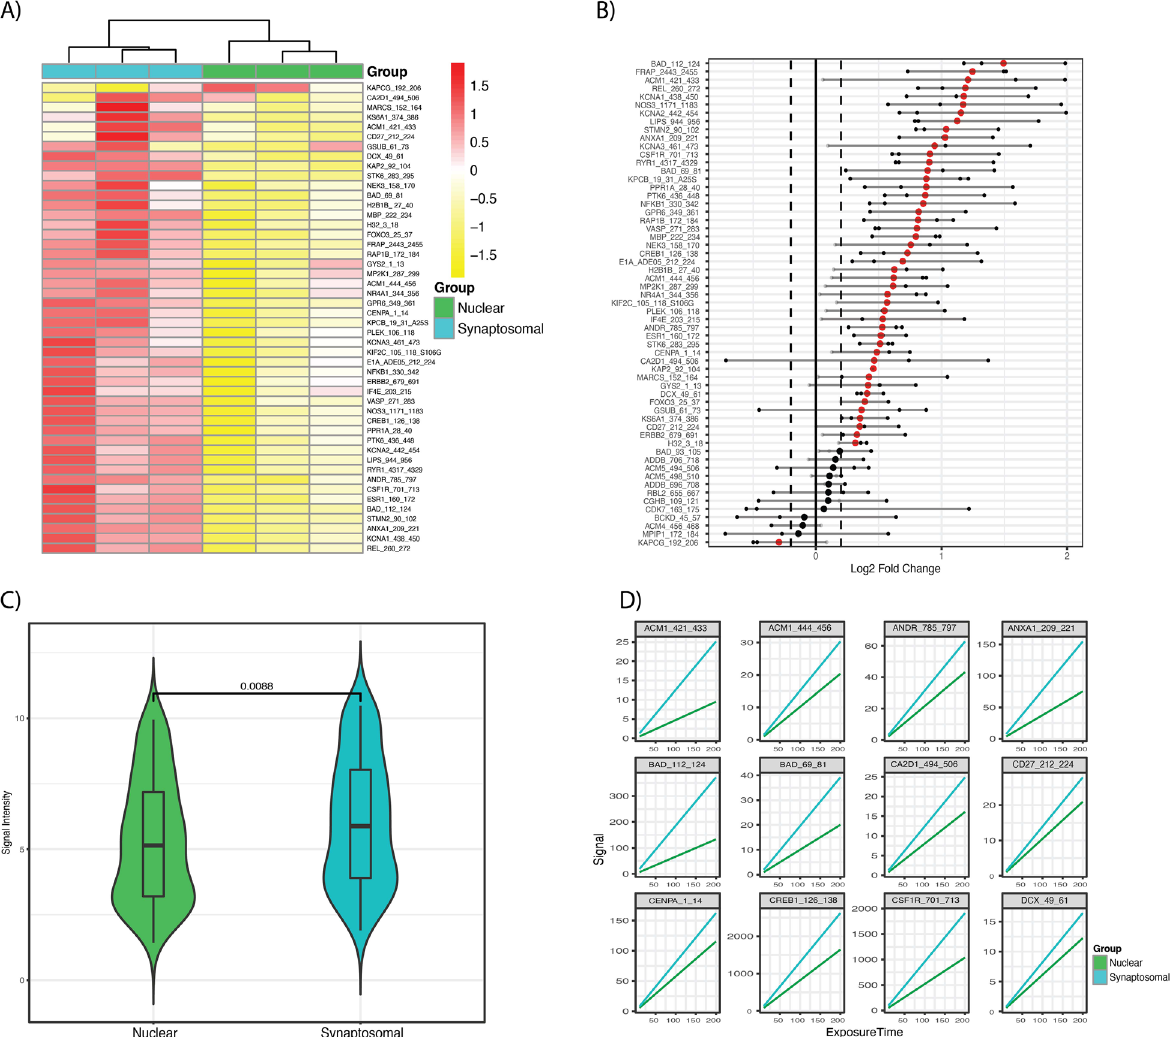
Figure 3. Active Kinome Profiles Comparison of Synaptosomal versus Nuclear Fractions. Two-way comparison of the synaptosomal versus nuclear fractions (nuclear is treated as the “control”). ( A ) Unsupervised hierarchical clustering of the signal intensity for the top differentially phosphorylated peptides. The values are normalized by peptide (Z-transformed) and represent relative phosphorylation. The heatmaps were generated using KRSA package (v0.10.3—https:// github. com/ CogDi sResL ab/ KRSA) using R version 4.1.2. ( B ) Waterfall showing the Log2 fold change of signal intensity across three chips (smaller points) and the mean Log2 fold change (large point). The color indicates if the mean Log2 fold change is larger than 0.2 or smaller than − 0.2. ( C ) Boxplot showing the mean global signal intensity of the two groups (synaptosomal and nuclear fractions) with a Wilcoxon signed-rank test. ( D ) The signal intensity as a function of exposure time (milliseconds) for a subset of the differentially phosphorylated